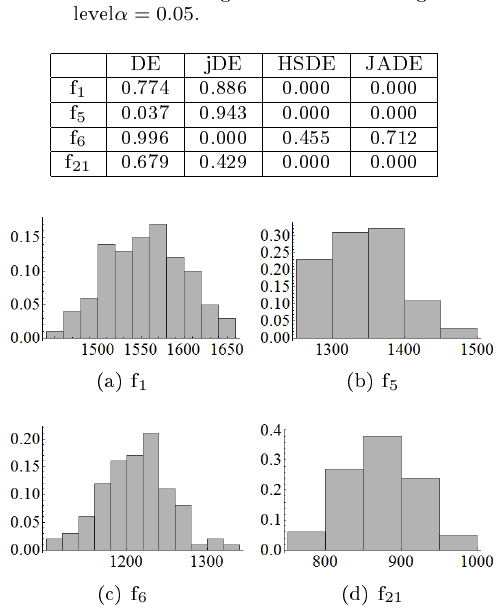
Fig. 4: The node out-strength distribution in the four aggregated networks generated on the basis of the DE/rand/1/bin dynamics.